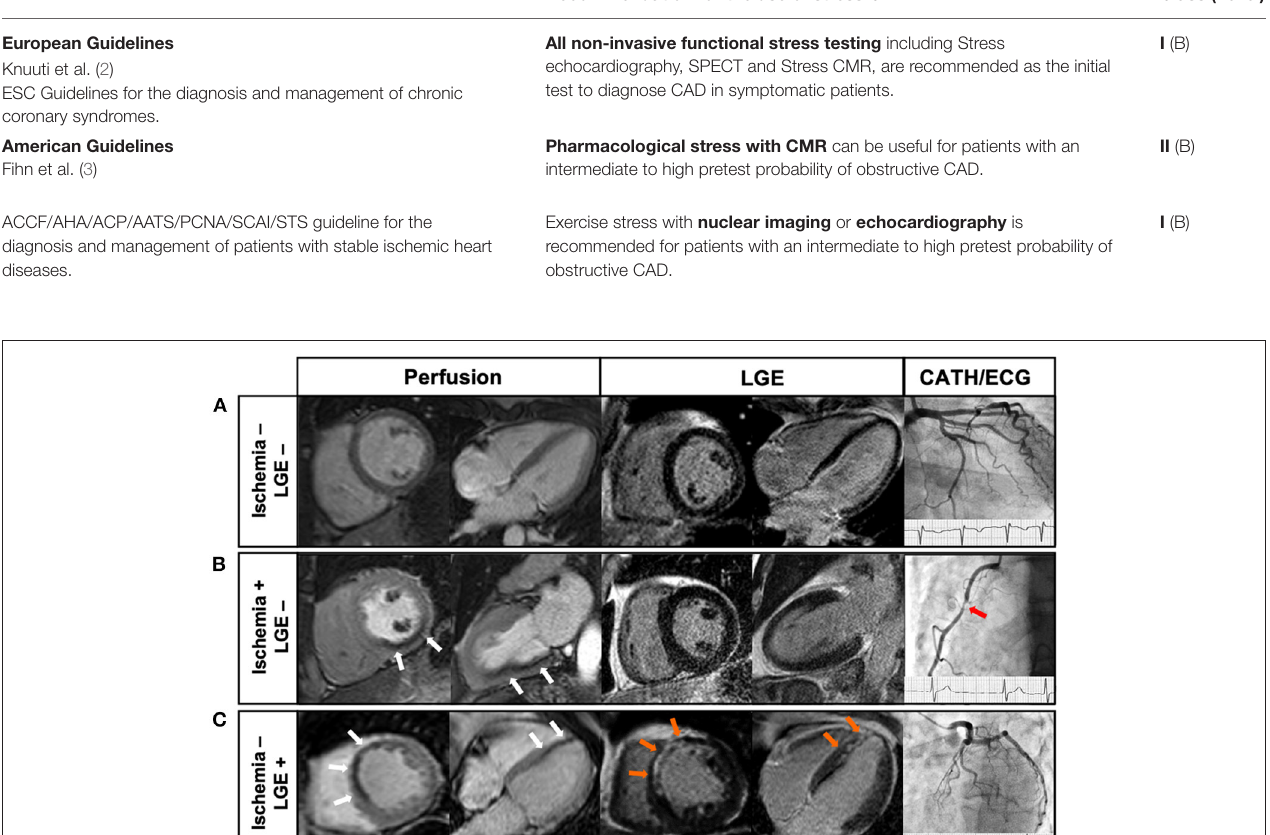
TABLE 1 | Comparison between European and American guidelines regarding the use of stress CMR. Recommendation for the use of stress CMR